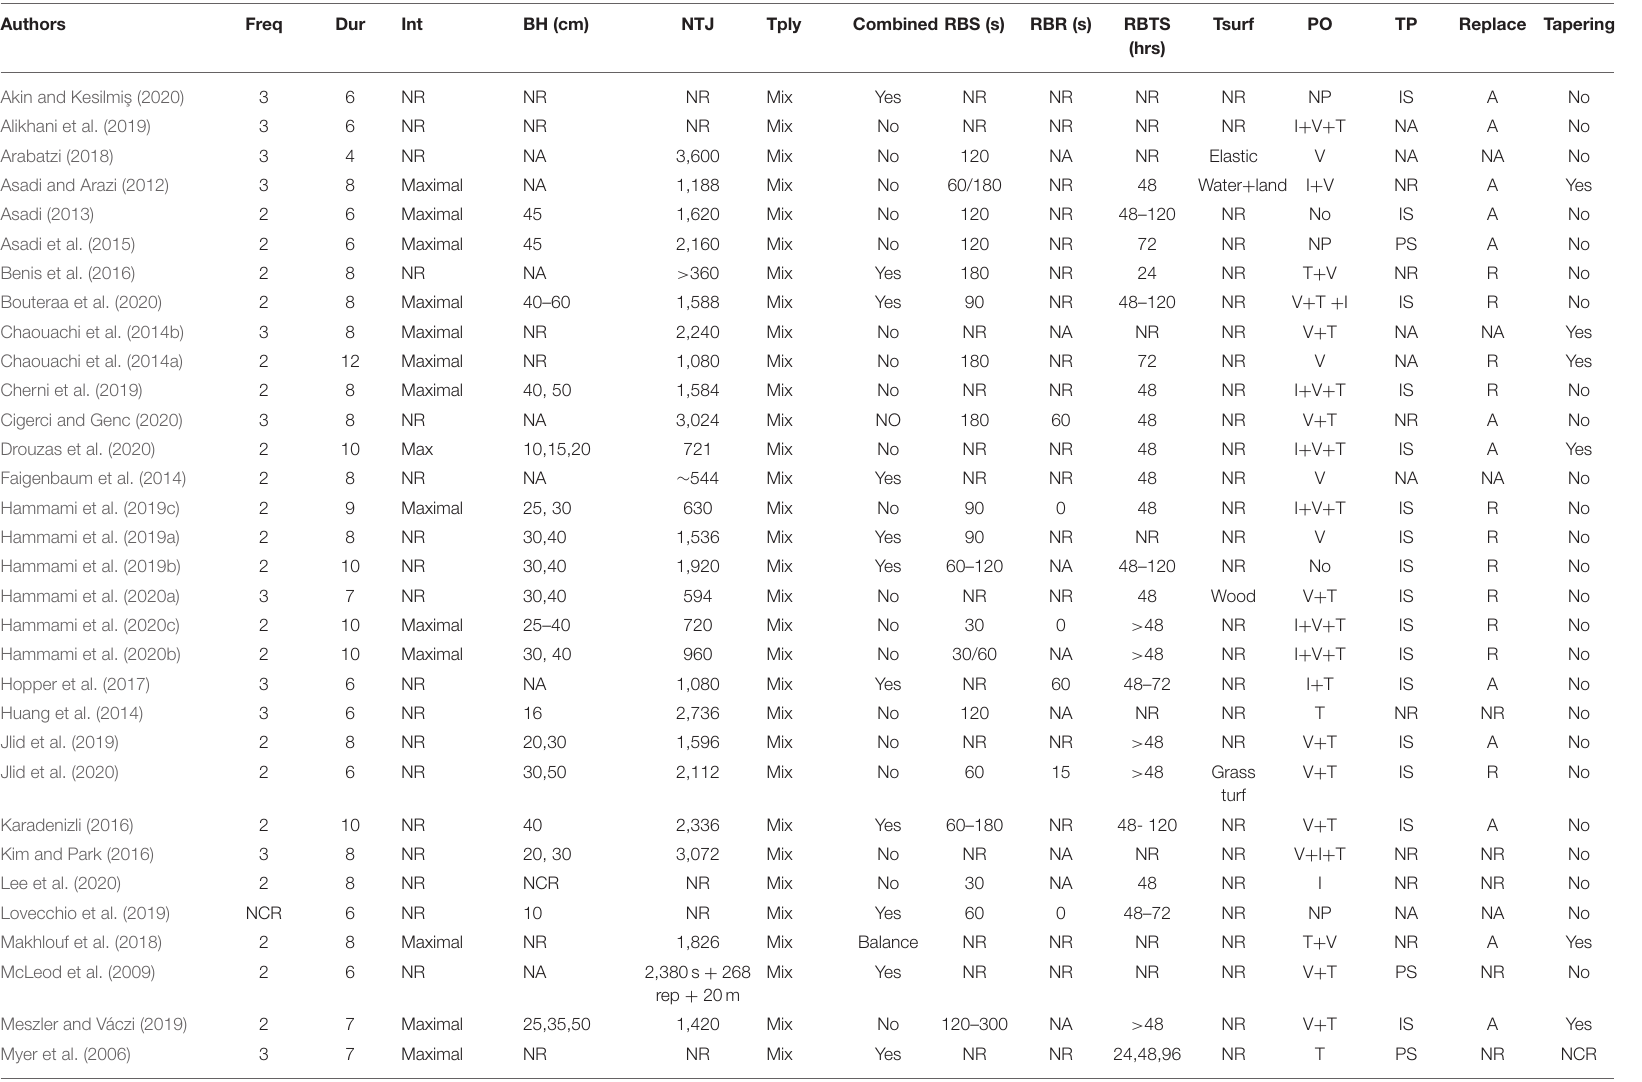
TABLE 3 | Characteristics of PJT interventions the included